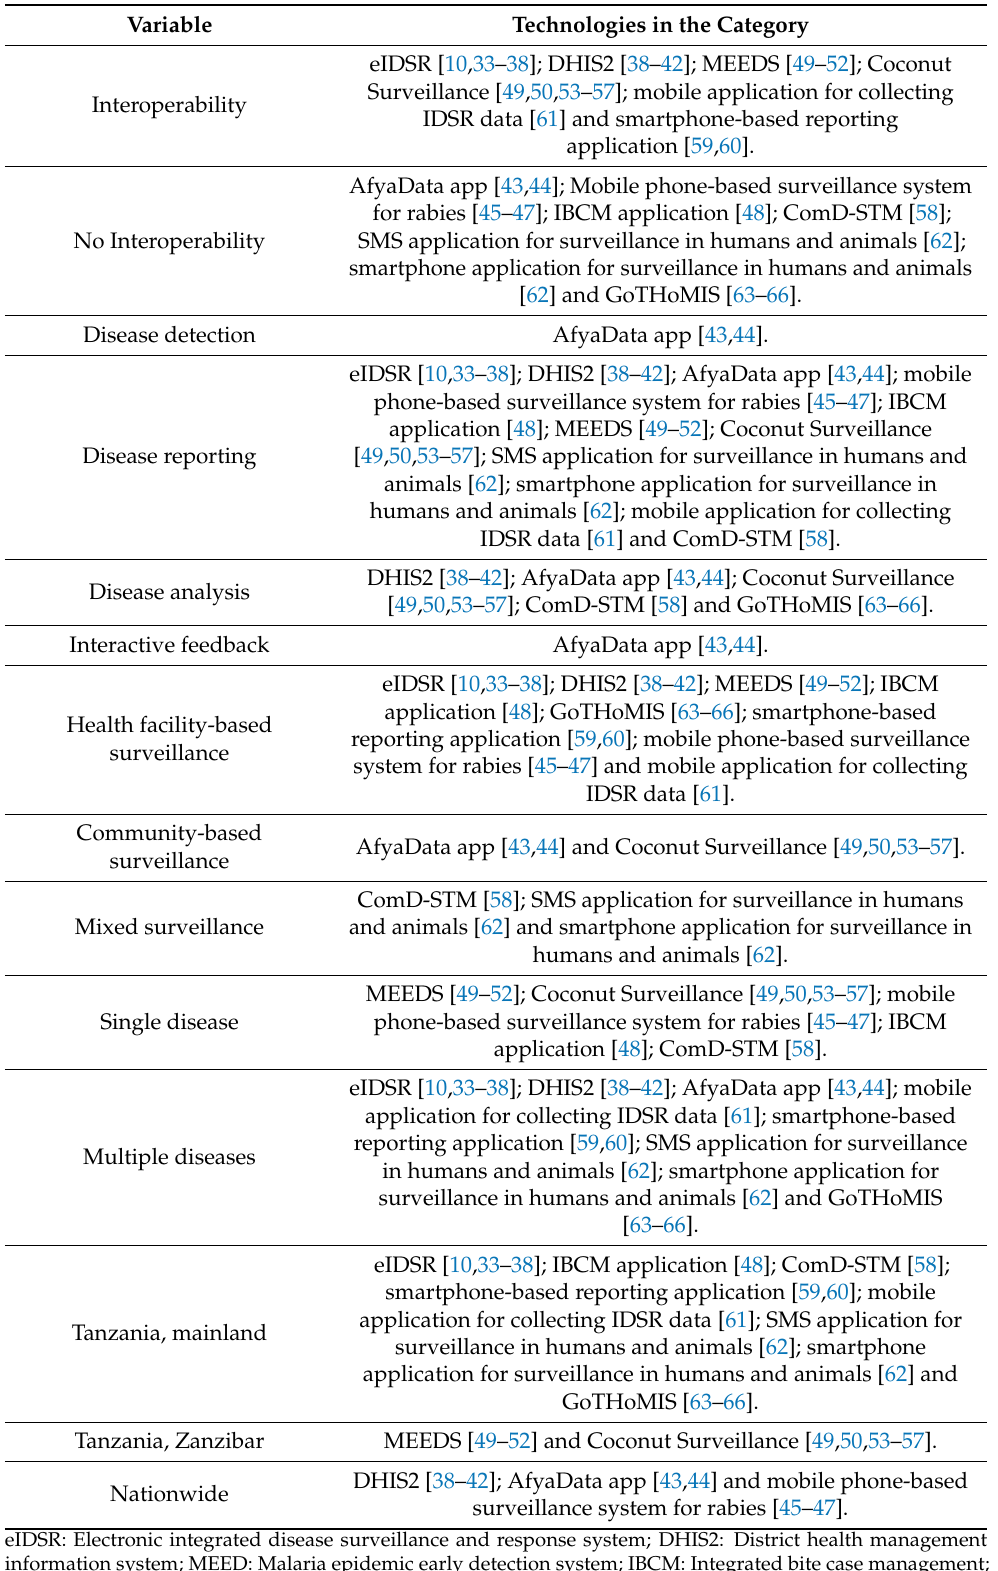
Table 4. Summary of characteristics of identified mobile phone-based systems and computer-based systems designed for infectious disease surveillance in